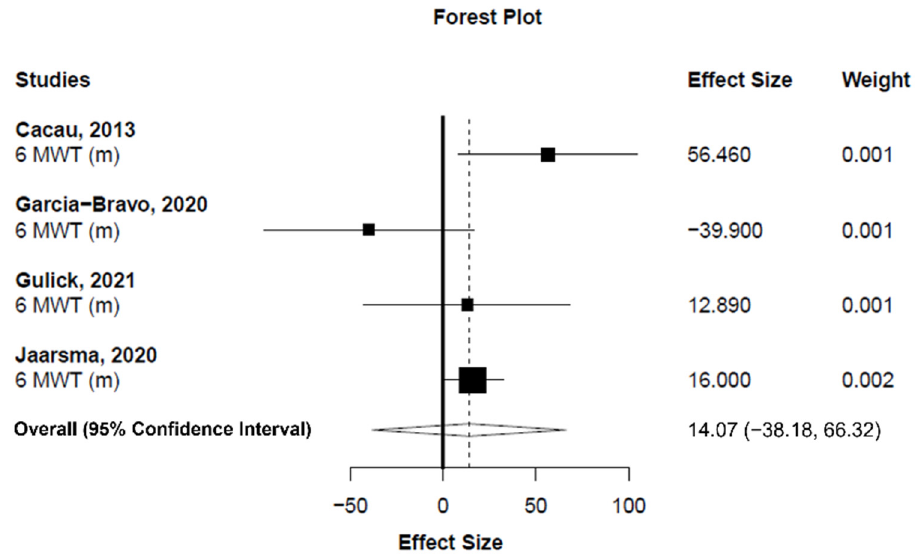
Figure 3. Forest plot showing the mean difference between exergaming and conventional cardiac rehabilitation for six-minute walk text. Mean difference higher than zero favors exergaming.